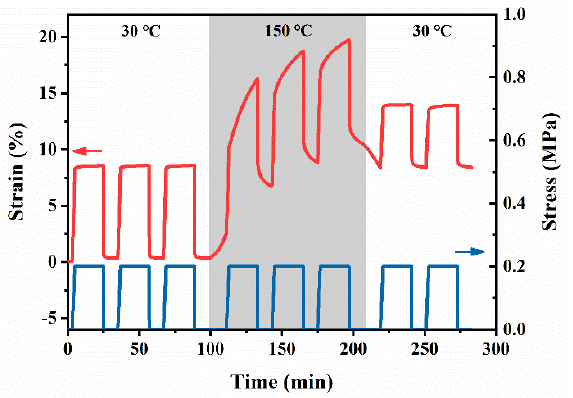
Figure 8. Cyclic strain recovery curves of vitrimer 4.